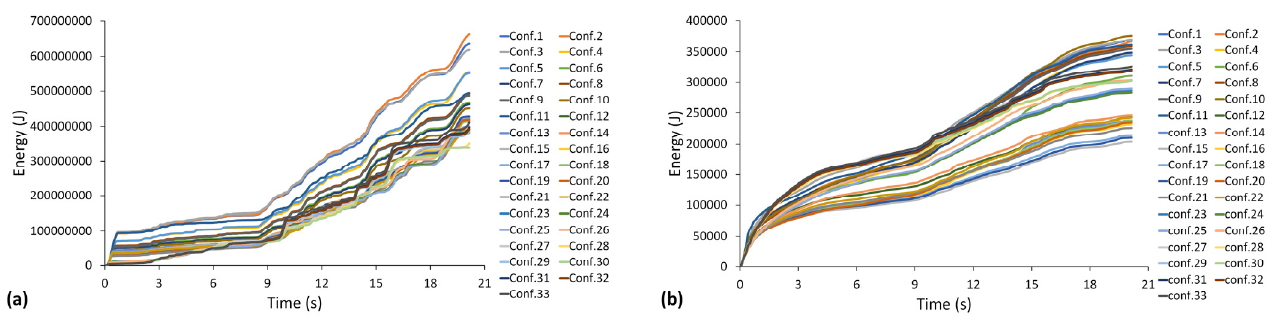
Figure 10. Energy dissipation in different configurations under the Nahanni earthquake: ( a ) plastic dissipation and ( b ) viscous dissipation.